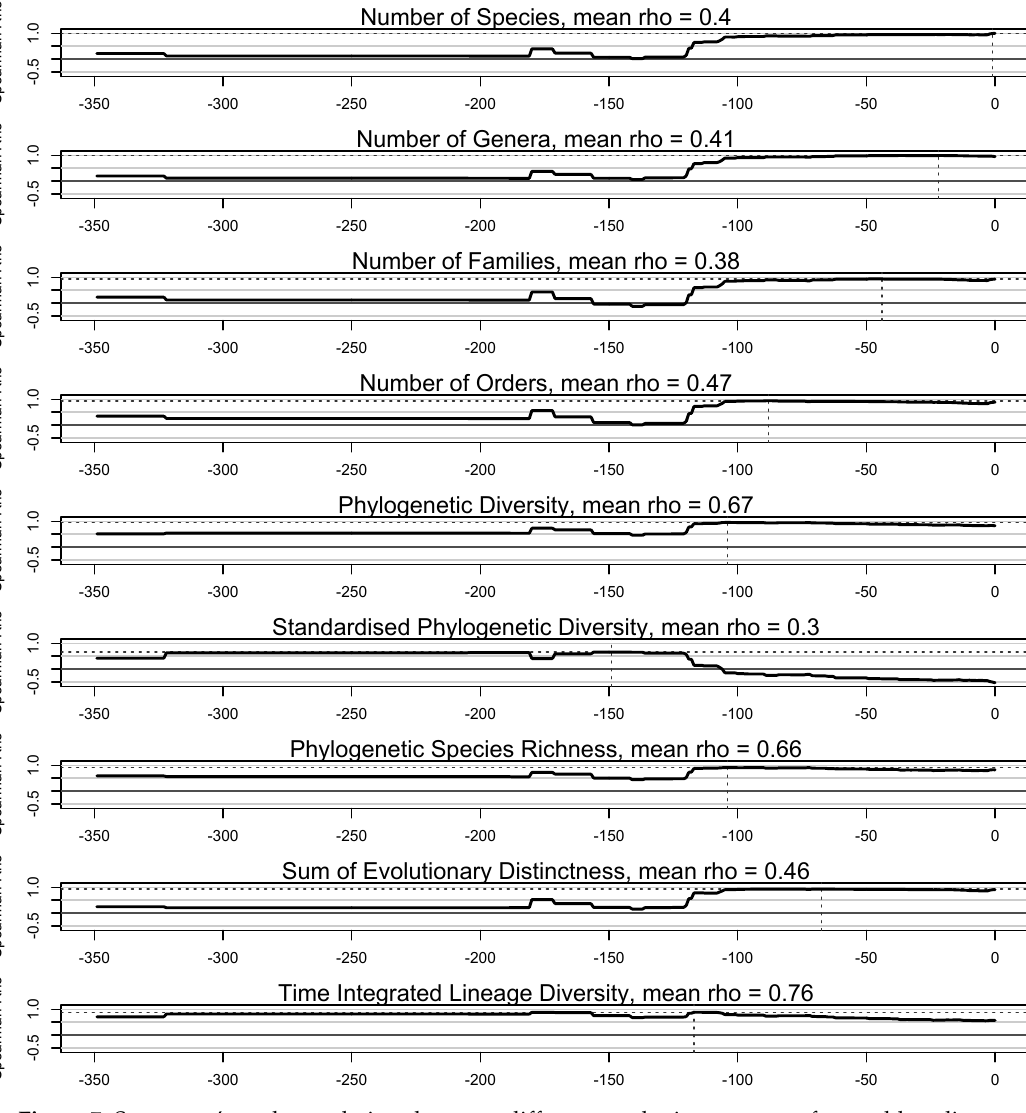
Sum of Evolutionary Distinctness, mean rho = 0.46